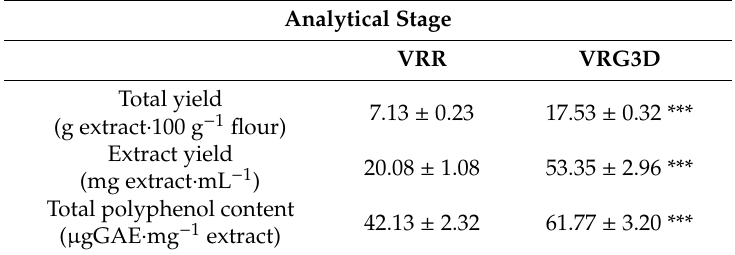
Table 3. E ff ect of 3-day-germination on extraction yield and total polyphenol content of mung bean